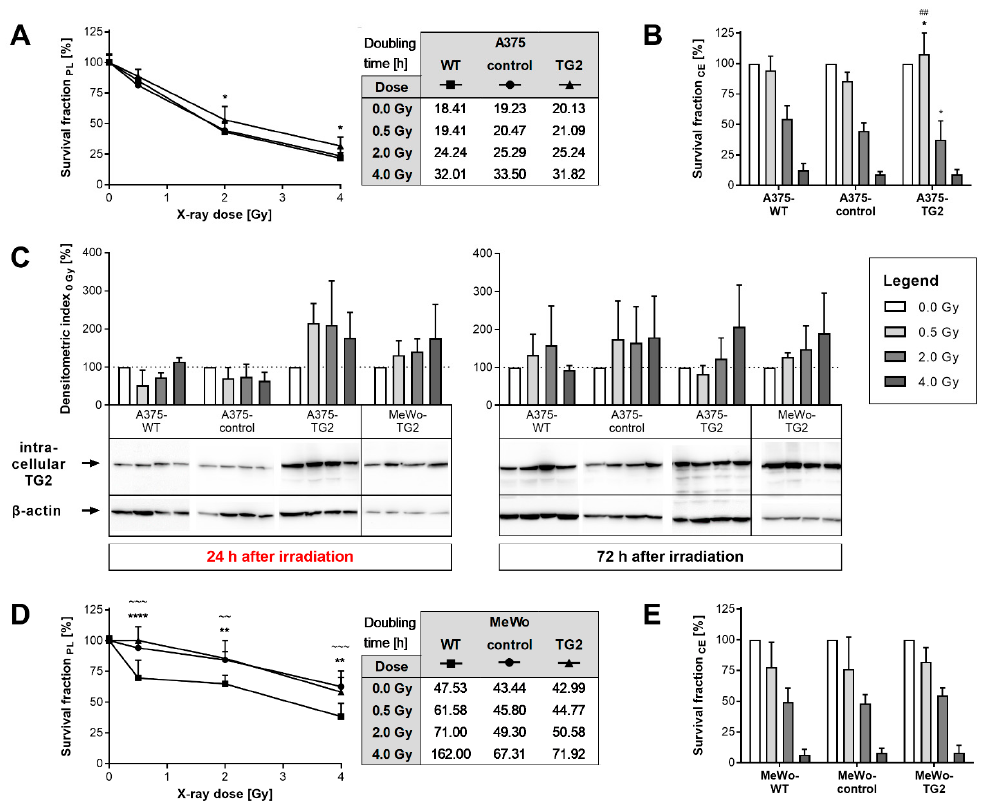
Figure 2. Proliferation, clonal expansion and TG2 biosynthesis of melanoma sub-cell lines after irradiation. ( A ) Proliferation (PL) of A375 sub-cell lines 72 h after irradiation. Survival fractions were calculated from cell counts normalized to non-irradiated (0 Gy) mean values of each cell line. Doubling times (h) over 72 h are indicated in the table. ( B ) Clonal expansion (CE) of A375 sub-cell lines after irradiation. Survival fractions resulted from plating efficiencies normalized to non-irradiated (0 Gy) values. For legend information see quadrangle below. ( C ) TG2 biosynthesis of A375 and MeWo sub-cell lines 24 h (left) and 72 h (right) after irradiation. TG2 biosynthesis was determined via Western blot using cell lysates and semi-quantitative densitometric analysis. Densitometric indices were calculated by normalization to ß-actin biosynthesis values and thereafter to respective non-irradiated (0 Gy) values of each cell line. ( D ) Proliferation (PL) of MeWo sub-cell lines 72 h after irradiation. Survival fractions were calculated from cell counts normalized to non-irradiated (0 Gy) mean values of each cell line. Doubling times (h) over 72 h are indicated in the table. ( E ) Clonal expansion (CE) of MeWo sub-cell lines after irradiation. Survival fractions resulted from plating efficiencies normalized to non-irradiated (0 Gy) values. For legend information see quadrangle above. Mean values ± SD from individual experiments (n ≥ 3) and representative blots are shown. Significant variances are displayed as * (TG2 vs. WT, p ≤ 0.05), ** (TG2 vs. WT, p ≤ 0.01), **** (TG2 vs. WT, p ≤ 0.0001), ## (TG2 vs. control, p ≤ 0.01), ~~ (control vs. WT, p ≤ 0.01), and ~~~ (control vs. WT, p ≤ 0.001).